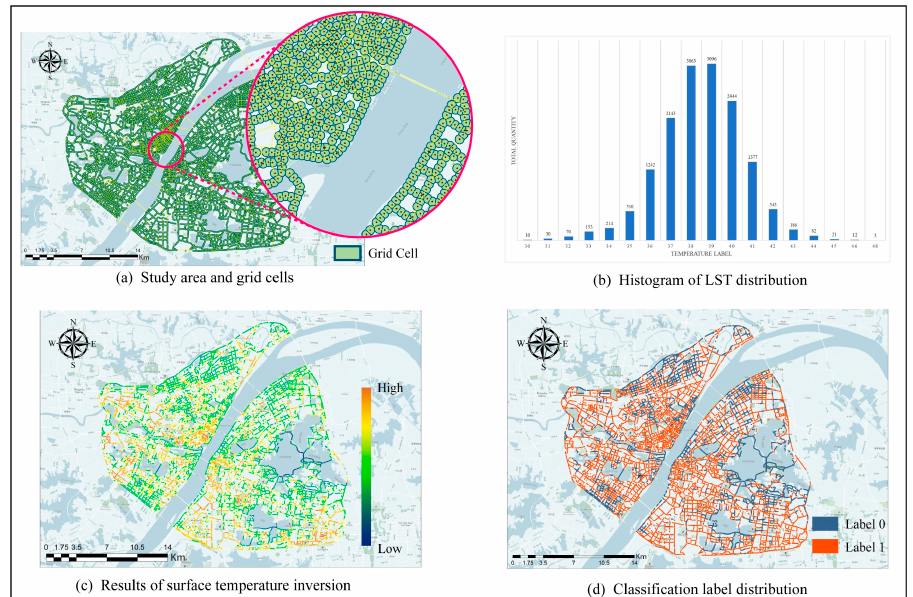
Figure 2. Study range and temperature label data